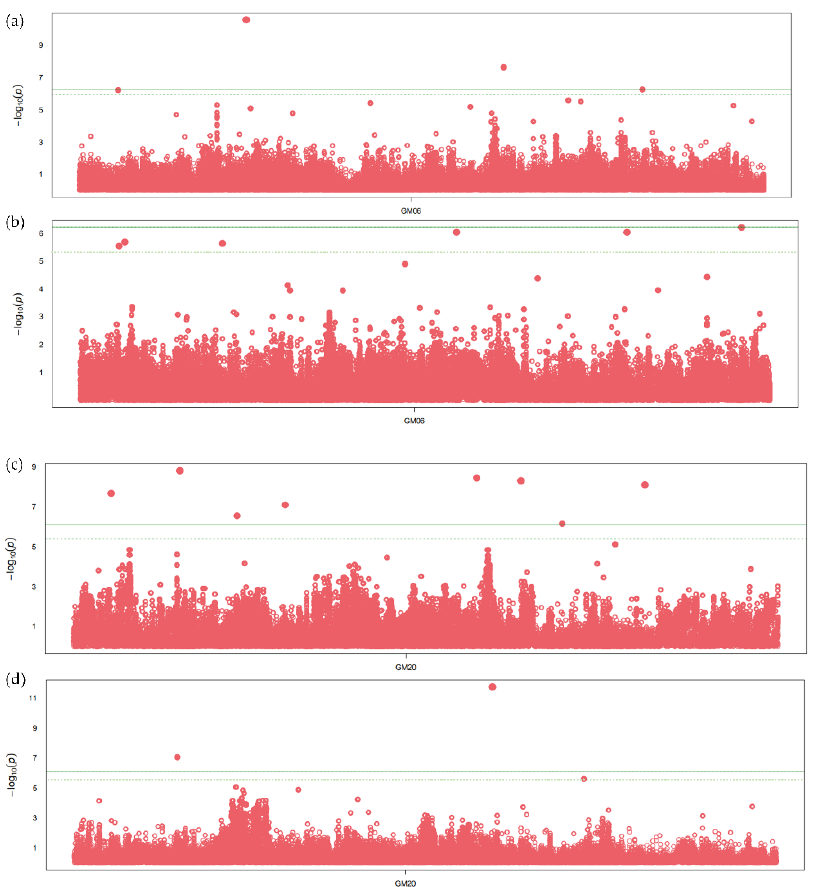
Figure 2. Manhattan plot showing significant SNP peaks and candidate genes on chromosome 6 associated with ( a ) seed oil content and ( b ) protein content, and chromosome 20 associated with ( c ) seed oil and ( d ) protein content. The candidate genes are shown in the vicinity of significant SNP peaks. The green line represents the threshold level based on Bonferroni correction.